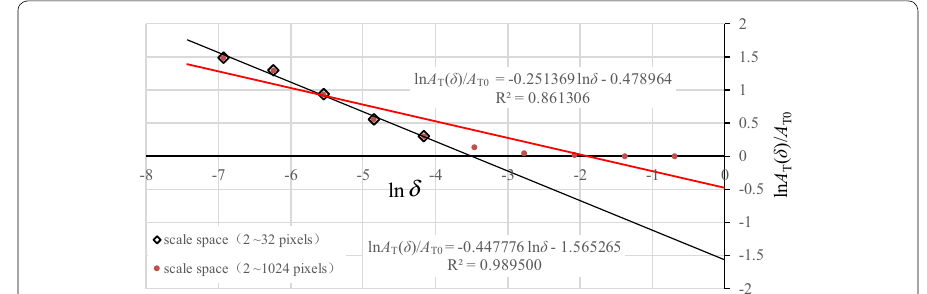
Fig. 10 Comparison diagram of fractal dimension fitting for the same surface at different